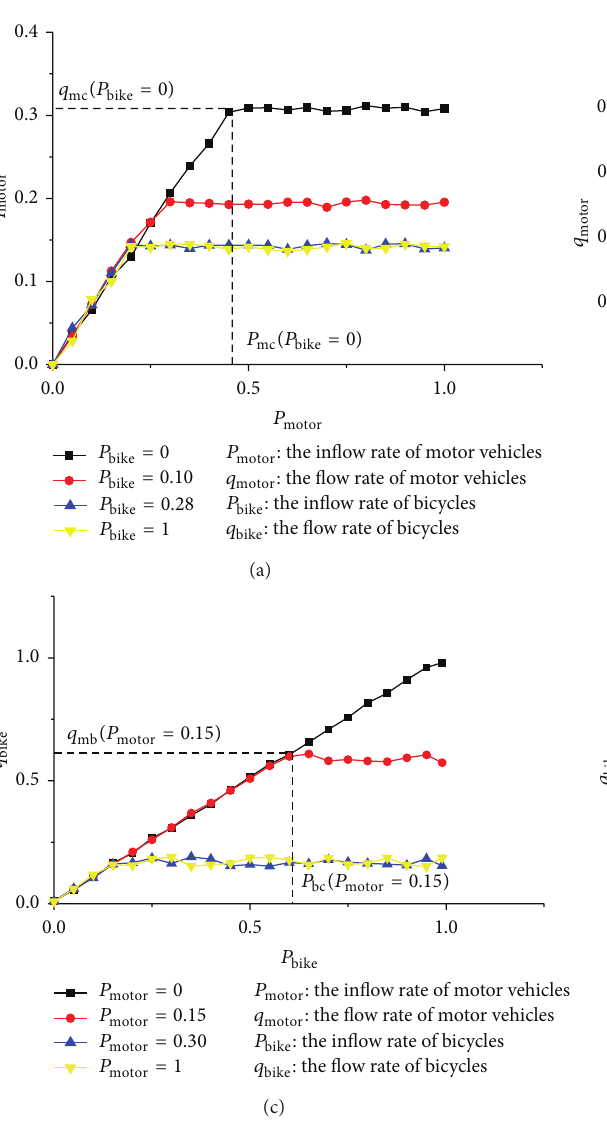
Figure 4: The simulation results of Type I bus